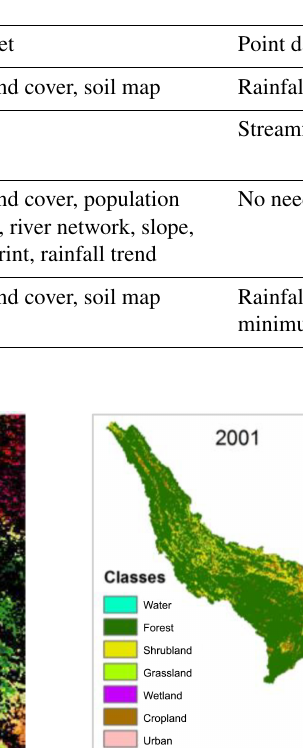
Table 1. Dataset summary for different models in the study.